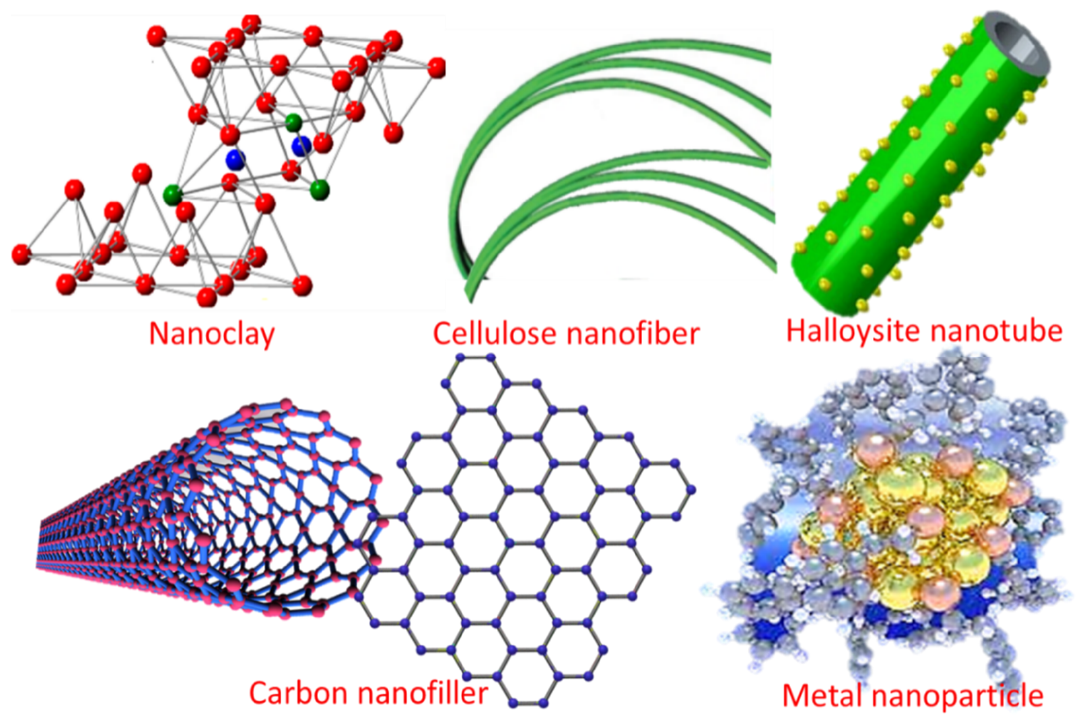
Figure 1. Green nanofillers.